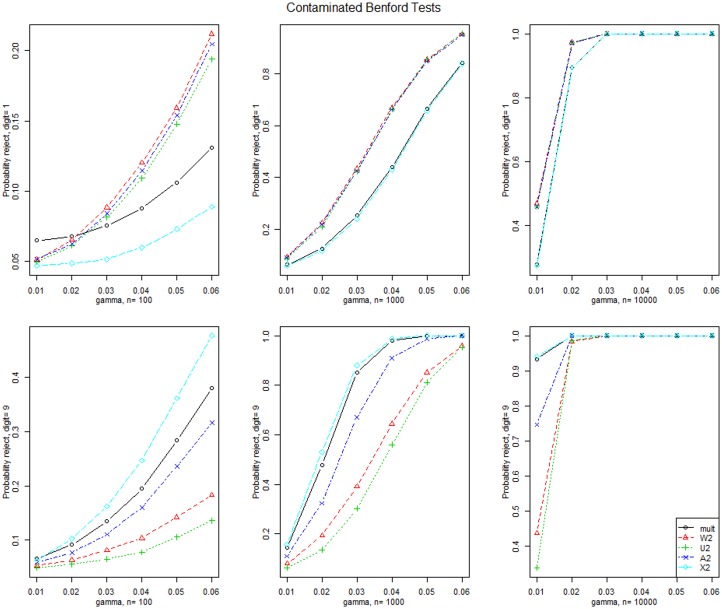
Contaminated Benford distribution test results.Simulated power for the tests when data are generated from the Contaminated Benford distribution where digits 1 and 9 are contaminated by an additive amount γ and for three sample sizes.